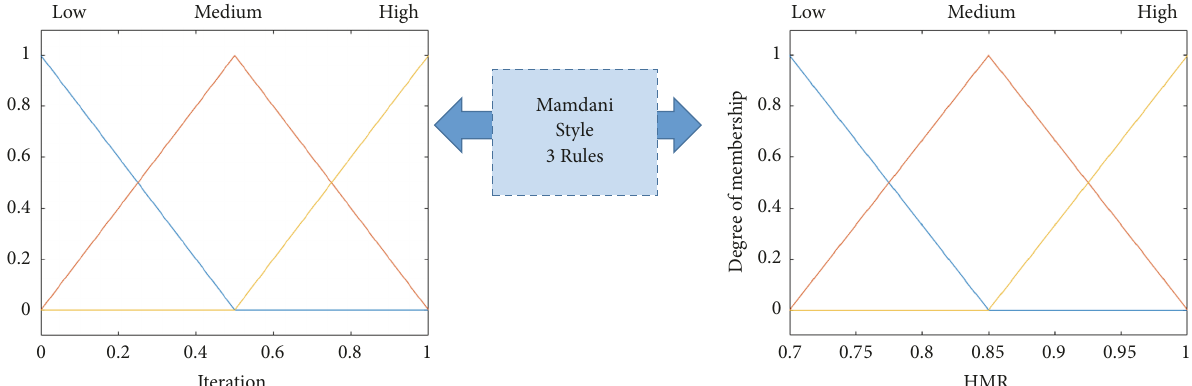
Figure 3: Plot of the type 1 proposed method (FHS).